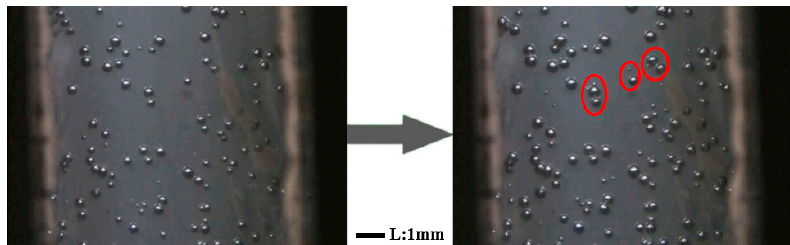
Figure 13. Photos of the secondary bubble growth of the PQ composites.